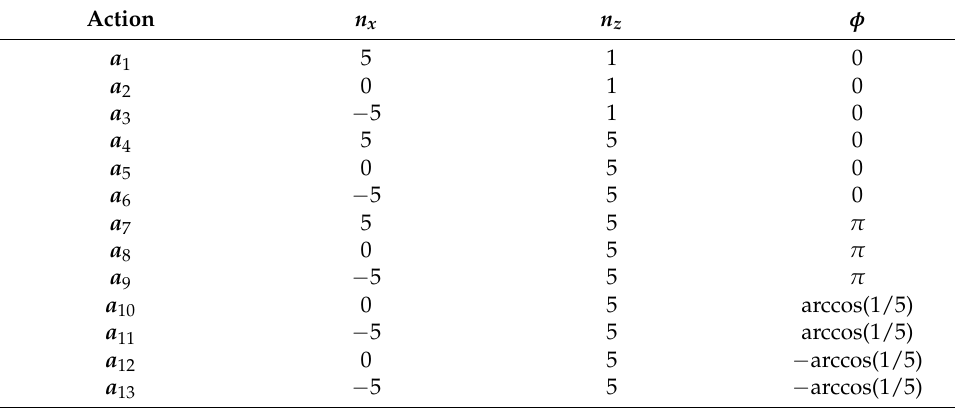
Table 1. Basic maneuver library.